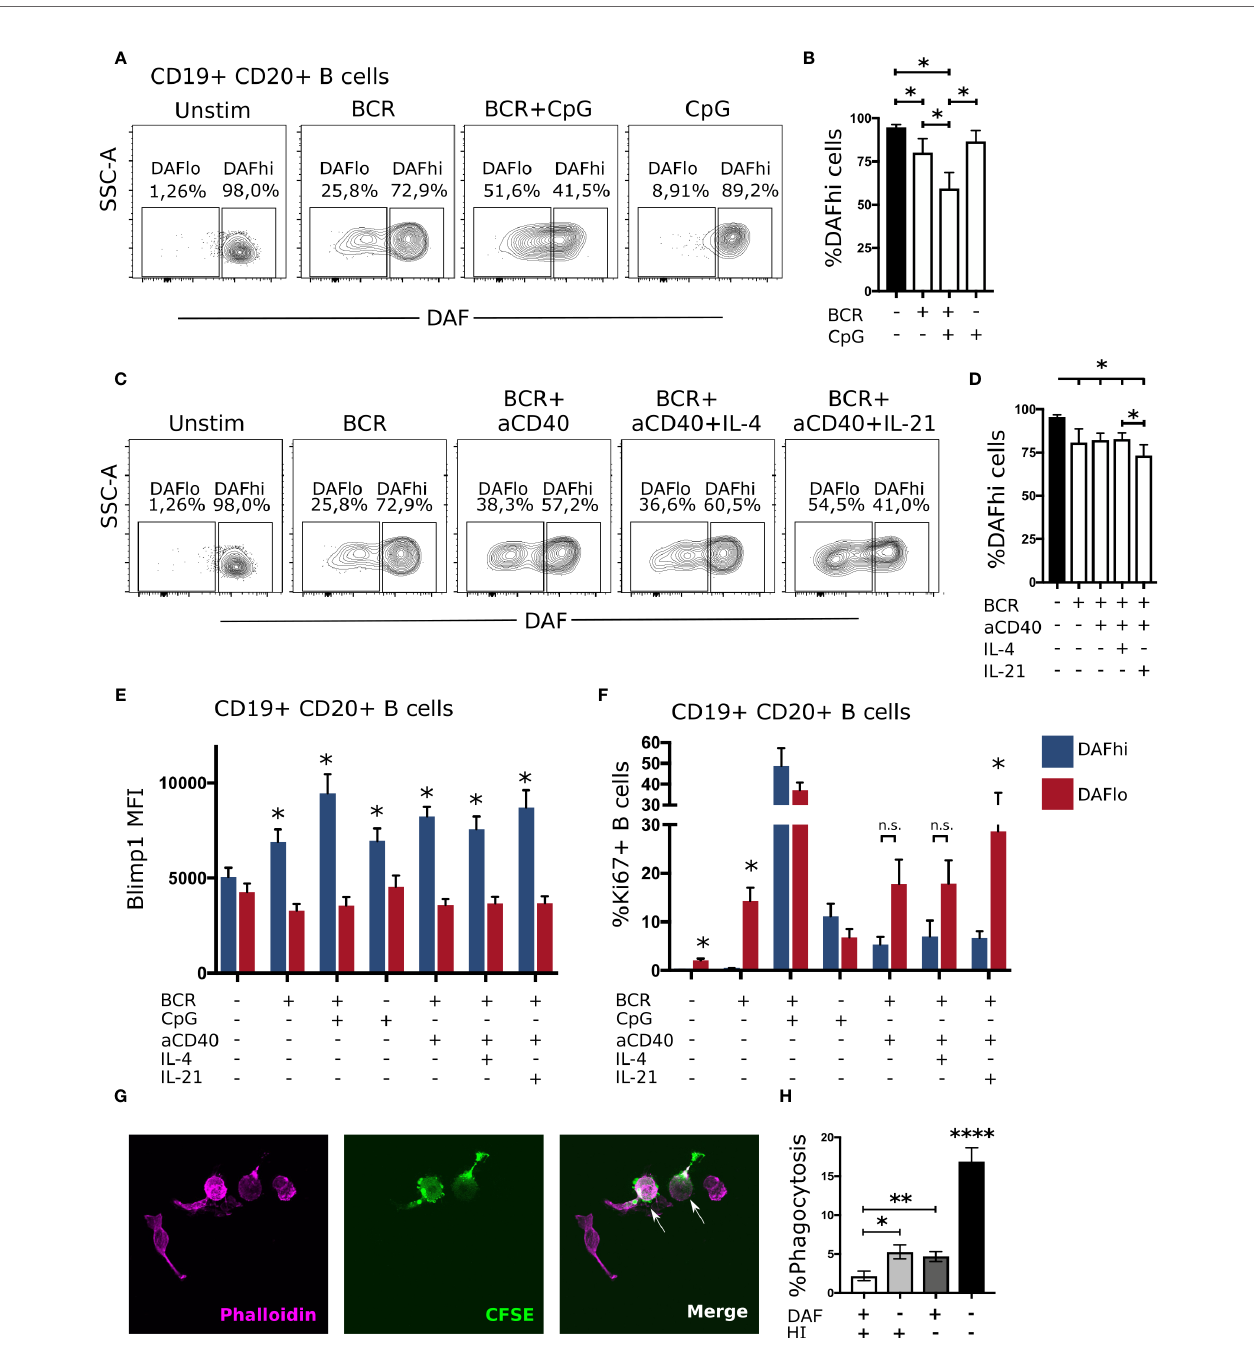
FIGURE 5 | B cell receptor engagement leads to downregulation of DAF on B cells, in vitro . (A) Representative plots for discriminating DAF expression on CD19 + CD20 + B cells 4 days after stimulation with anti-IgM/IgG, CpG, or a combination of both. (B) Quanti fi cation of data from (A) . N = 6. Median and interquartile range is shown. (C) Representative plots for discriminating DAF expression on CD19 + CD20 + B cells 4 days after stimulation with anti-IgM/IgG, anti-CD40, IL-4, IL-21, or a combination of these. (D) Quanti fi cation of data from (C) . N = 6. Median and interquartile range is shown. Intracellular expression of Blimp1 (E) or Ki67 (F) in DAF hi and DAF lo B cells after 4-day stimulation with anti-IgM/IgG, CpG, anti-CD40, IL-4, IL-21, or a combination of these. N = 6. Median and interquartile range is shown. *P < 0,05 by Wilcoxon signed-rank test. (G) Representative image of phalloidin labeled primary human macrophages (magenta), CFSE stained sorted B cells (green), and phagocytosed B cells (magenta and green). (H) Quanti fi cation of phagocytosed B cells after co-incubation of sorted and CFSE labeled DAF hi and DAF lo GC B cells with human serum before or after heat inactivation (HI). Two hundred macrophages were counted per slide and cells double positive for CFSE and phalloidin were considered phagocytosing. Data from three independent experiments is shown (GC B cells from three unique individuals). Mean and standard error of mean is shown. *P < 0,05; **P < 0,01; ****P < 0,0001 by Mann-Whitney